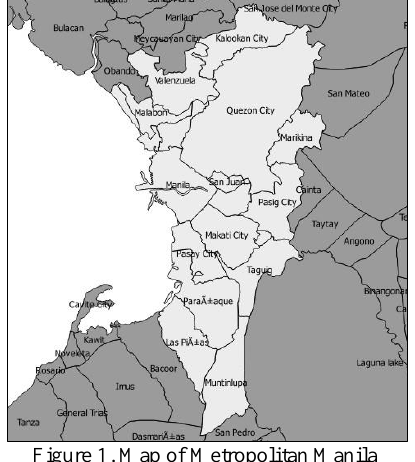
Figure 1. Map of Metropolitan